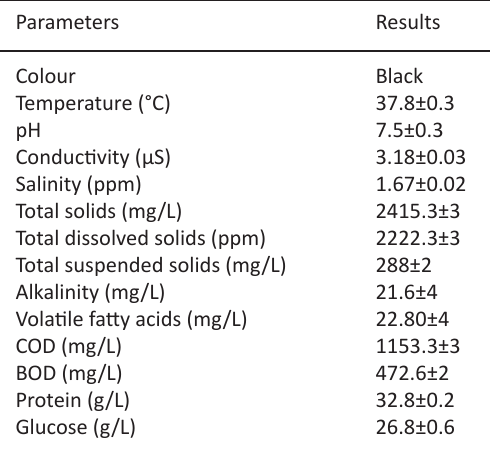
Table 1. Physicochemical Characteristics of the Dairy Industry anaerobic sludge